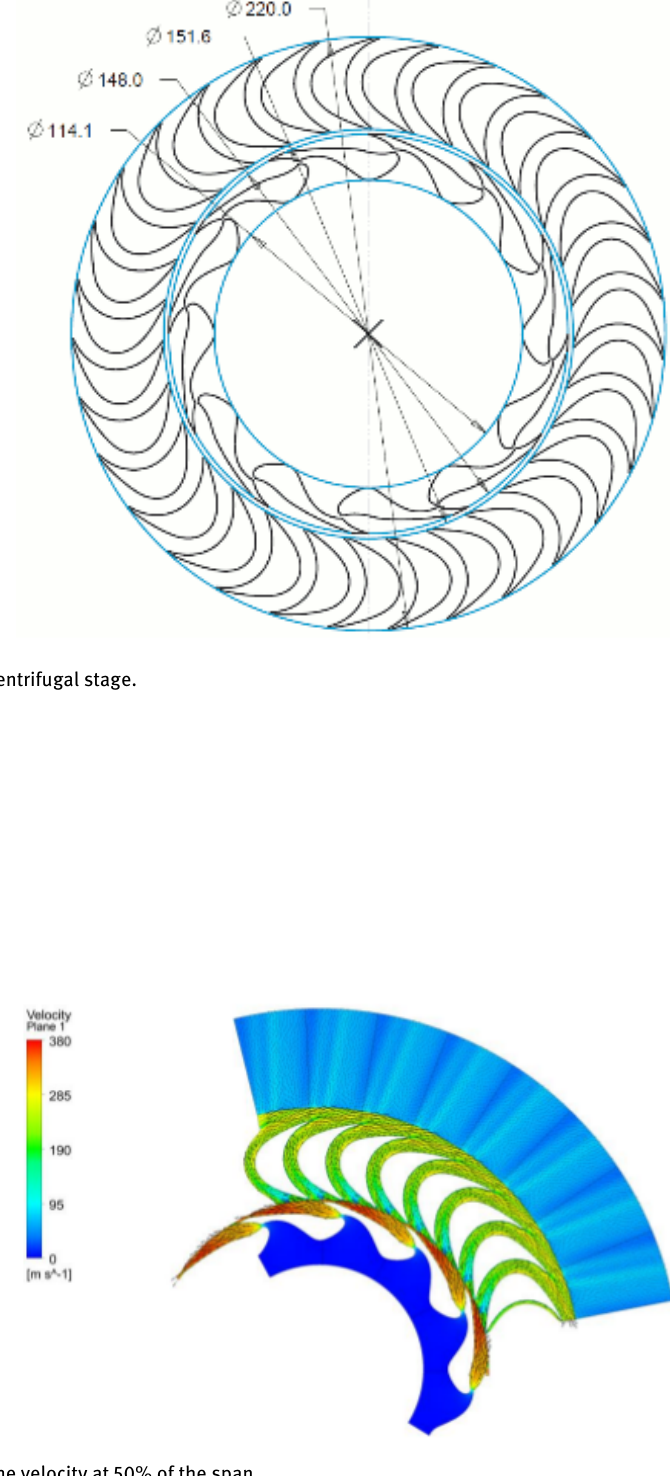
Figure 5: The distribution of the velocity at 50% of the